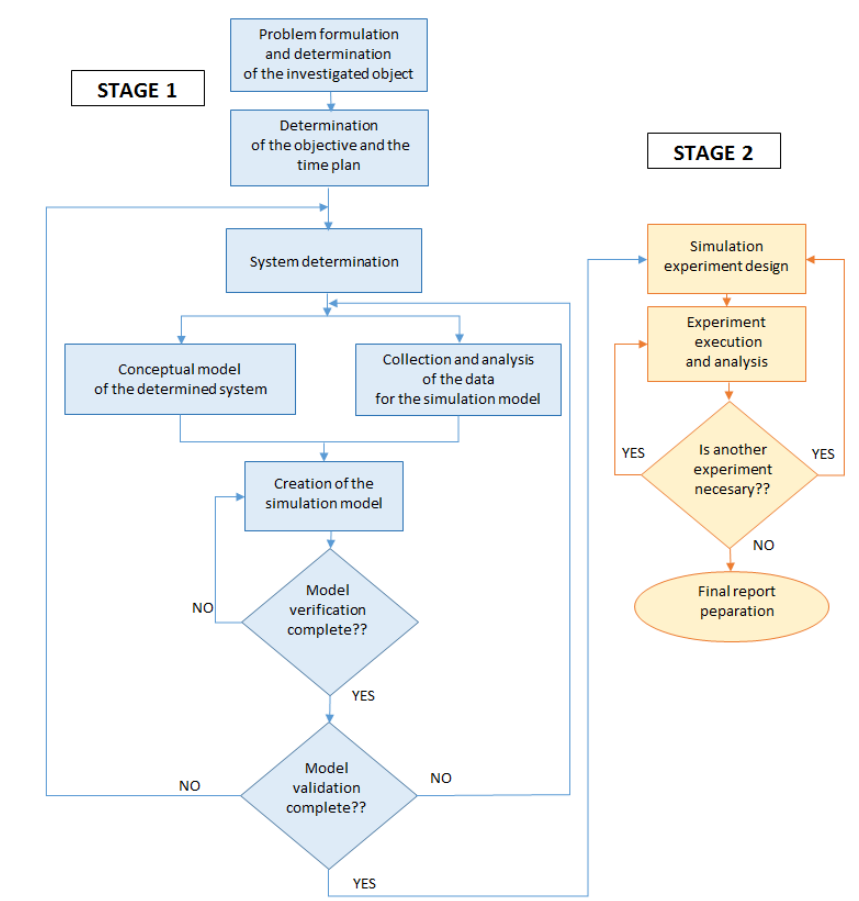
Figure 1: Simulation model creation